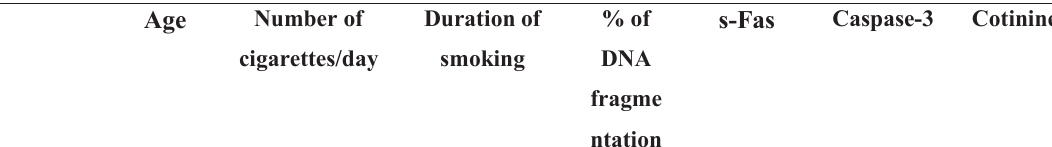
Table 5 - Correlation coefficient (r) among various bioindices in infertile Table 5. Correlation coefficient (r) among various bioindices in infertile smokers.